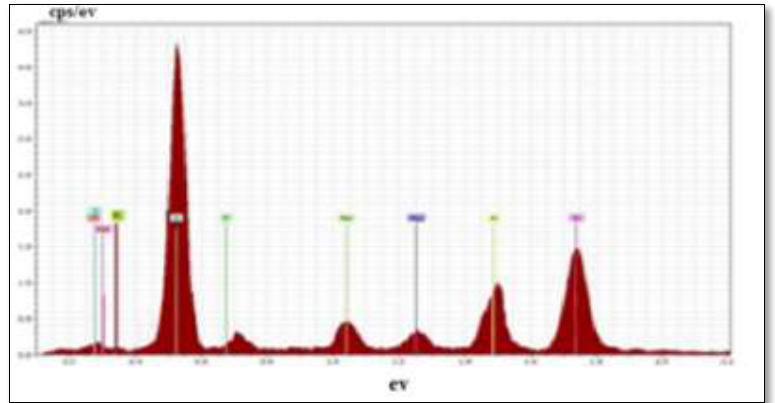
Figure 10: explain Kaolin-mortar after exposure thermal treatment